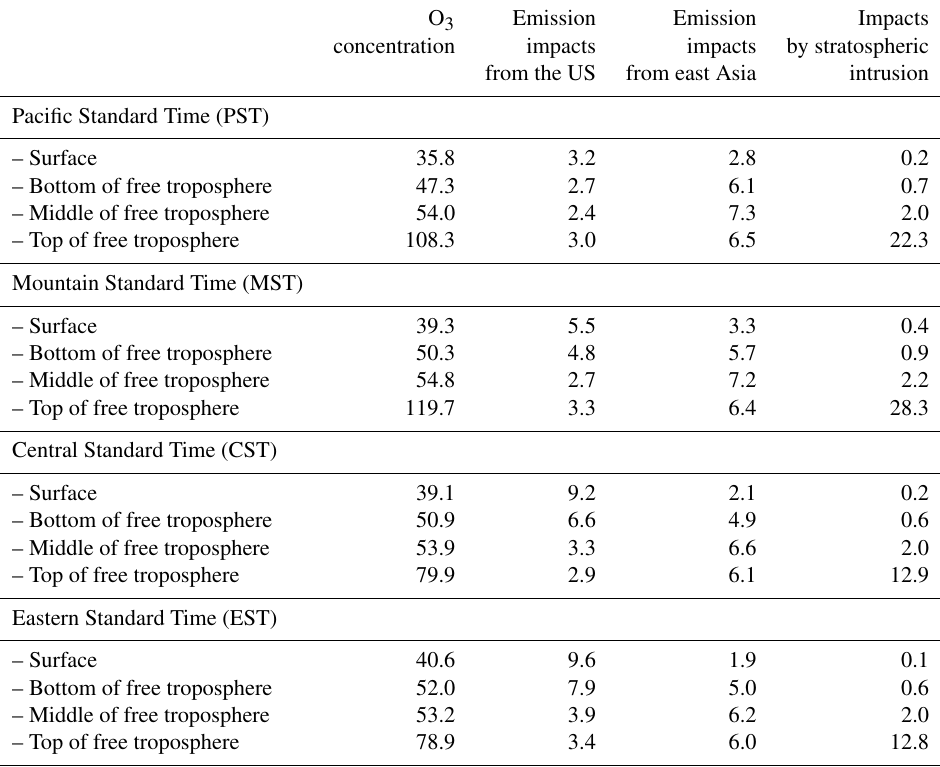
Table 2. Summary of O 3 concentration and zero-out contribution of emissions from the US and east Asia, and sensitivity of O3VORT over four time zones in the US during April 2010. O 3 Emission Emission Impacts concentration impacts impacts by stratospheric from the US from east Asia